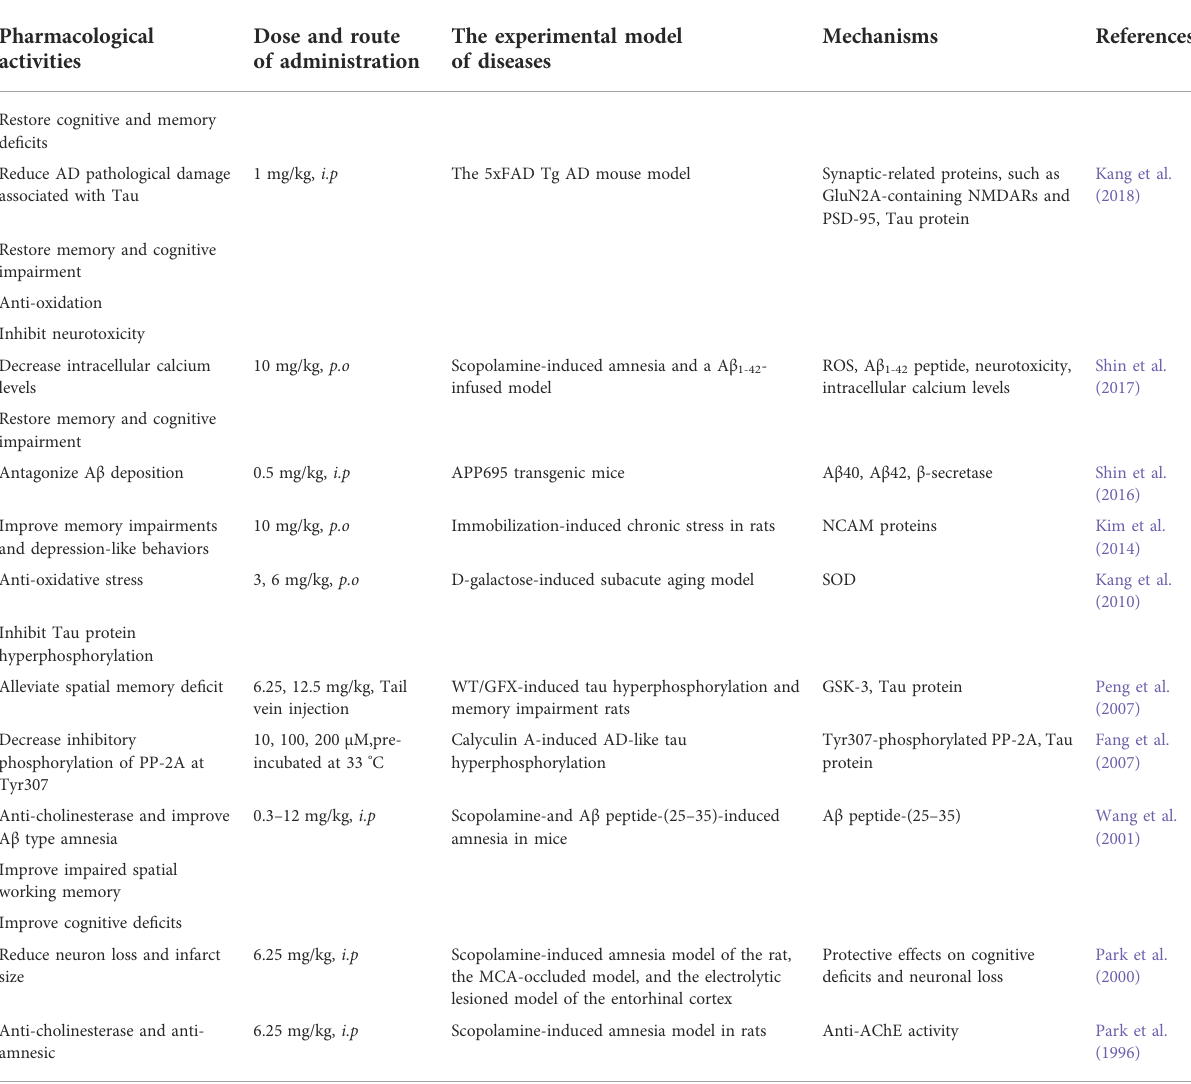
TABLE 2 Pharmacological effects of DHE on various central nervous system